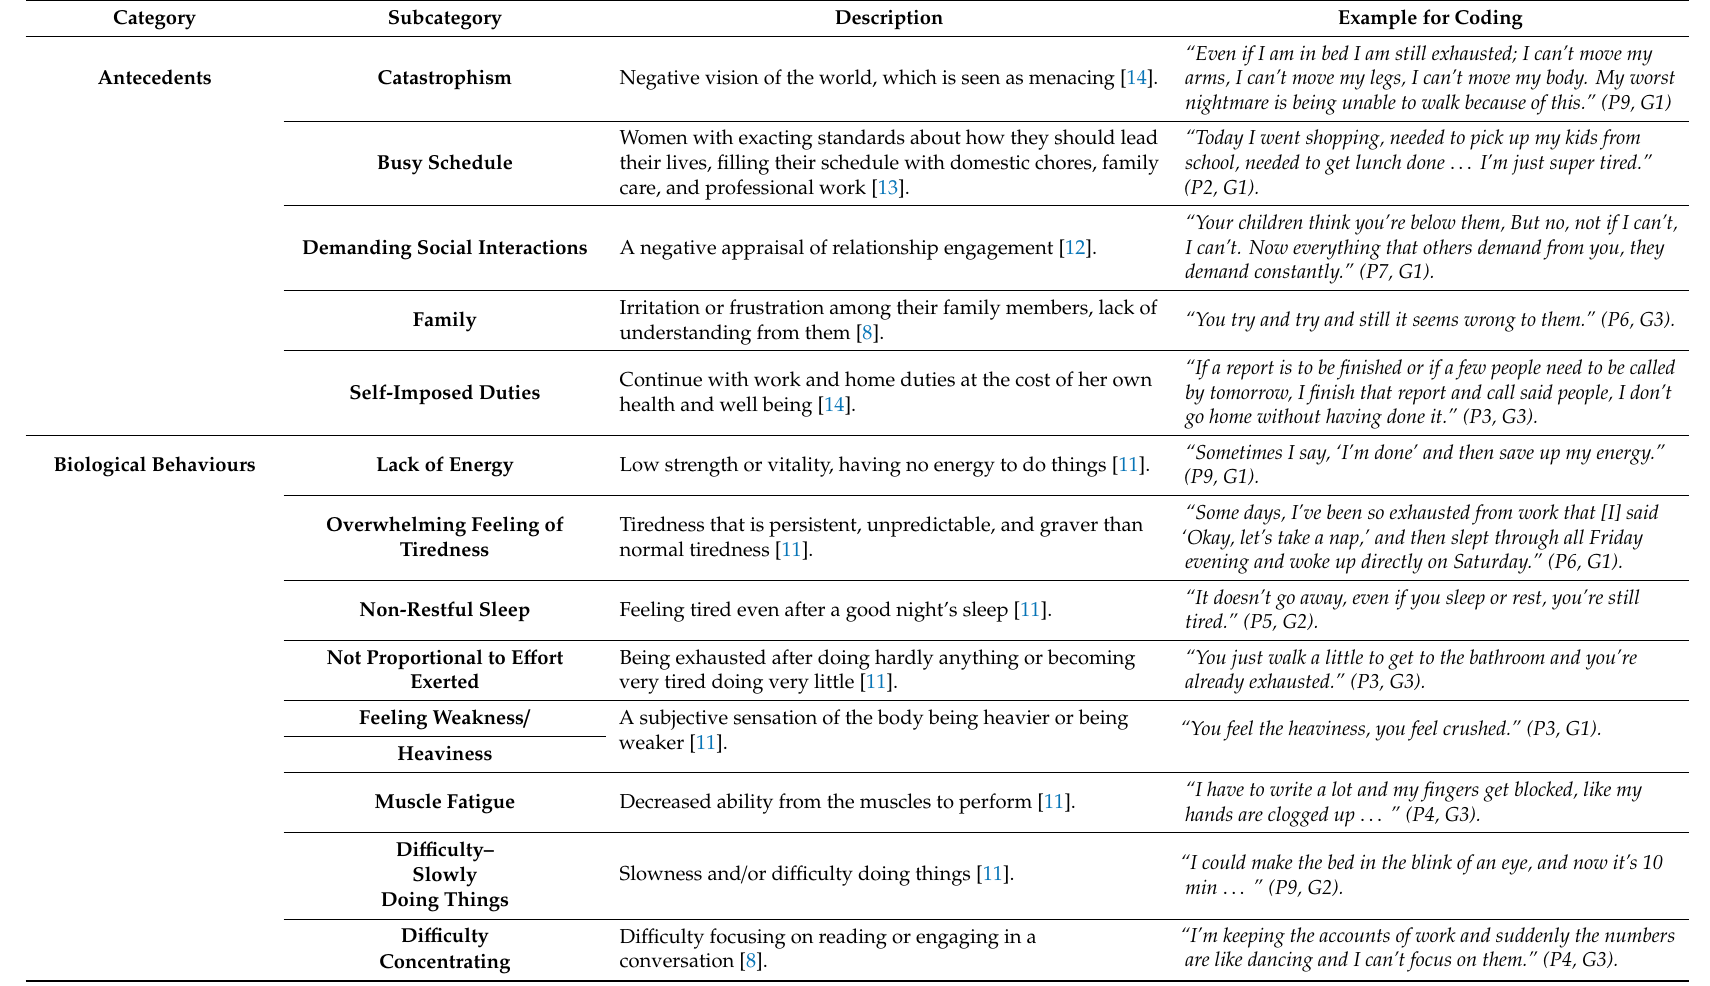
Table 4. Categories, subcategories, descriptions, and examples of the